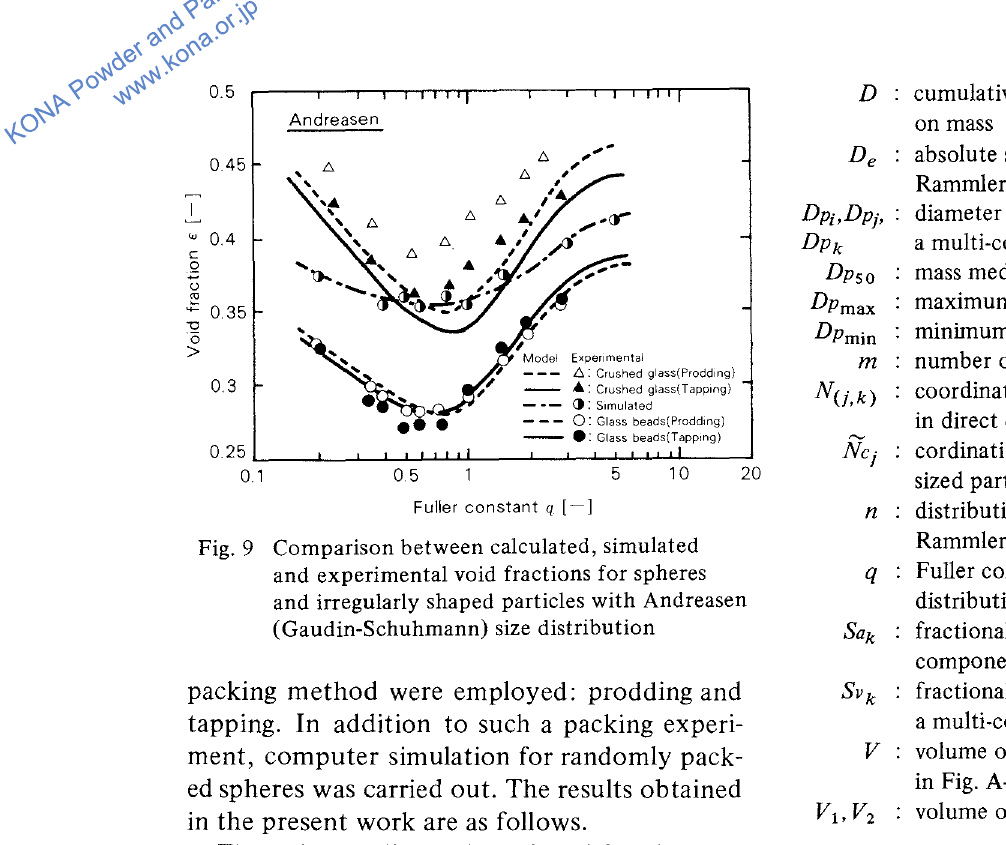
Fig. 9 Comparison between calculated, simulated and experimental void fractions for spheres and irregularly shaped particles with Andreasen